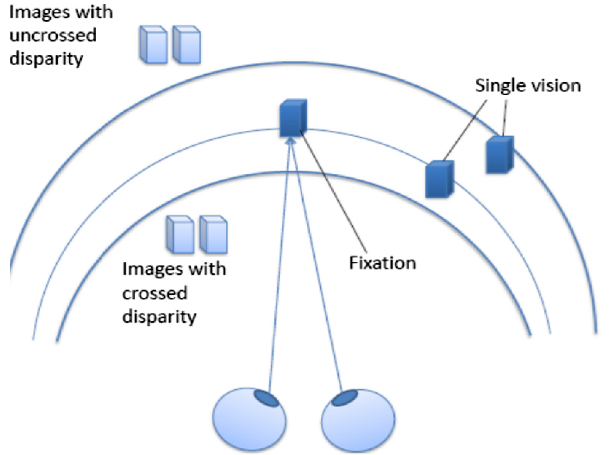
Fig. 3 Panum’s fusional area: objects within the area are perceived as single images, objects further away are seen perceived with uncrossed disparity, and the objects closer to the viewer with crossed disparity. Reproduced with permission from Ref. [63], c (cid:13) ACM 2010.